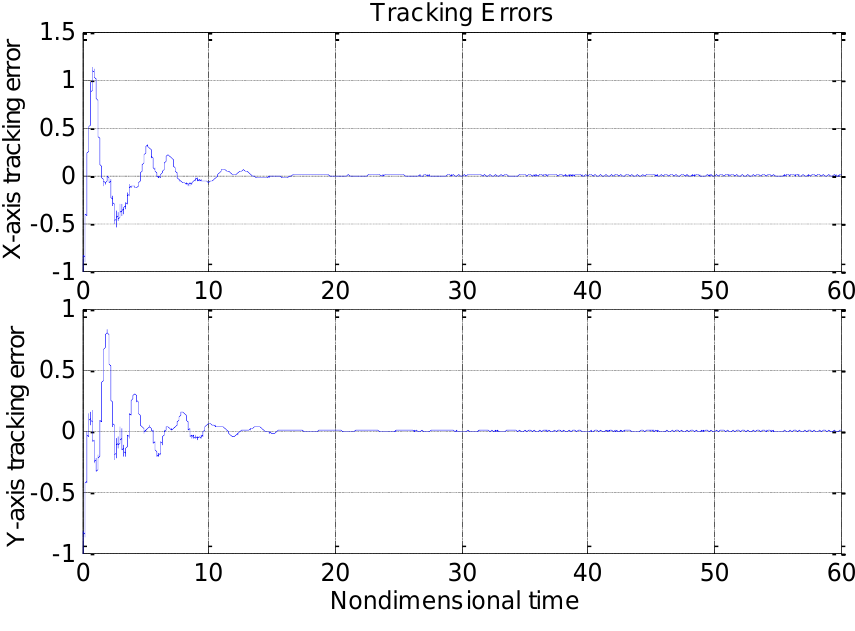
Figure 9. Tracking errors using the adaptive controller in [2].